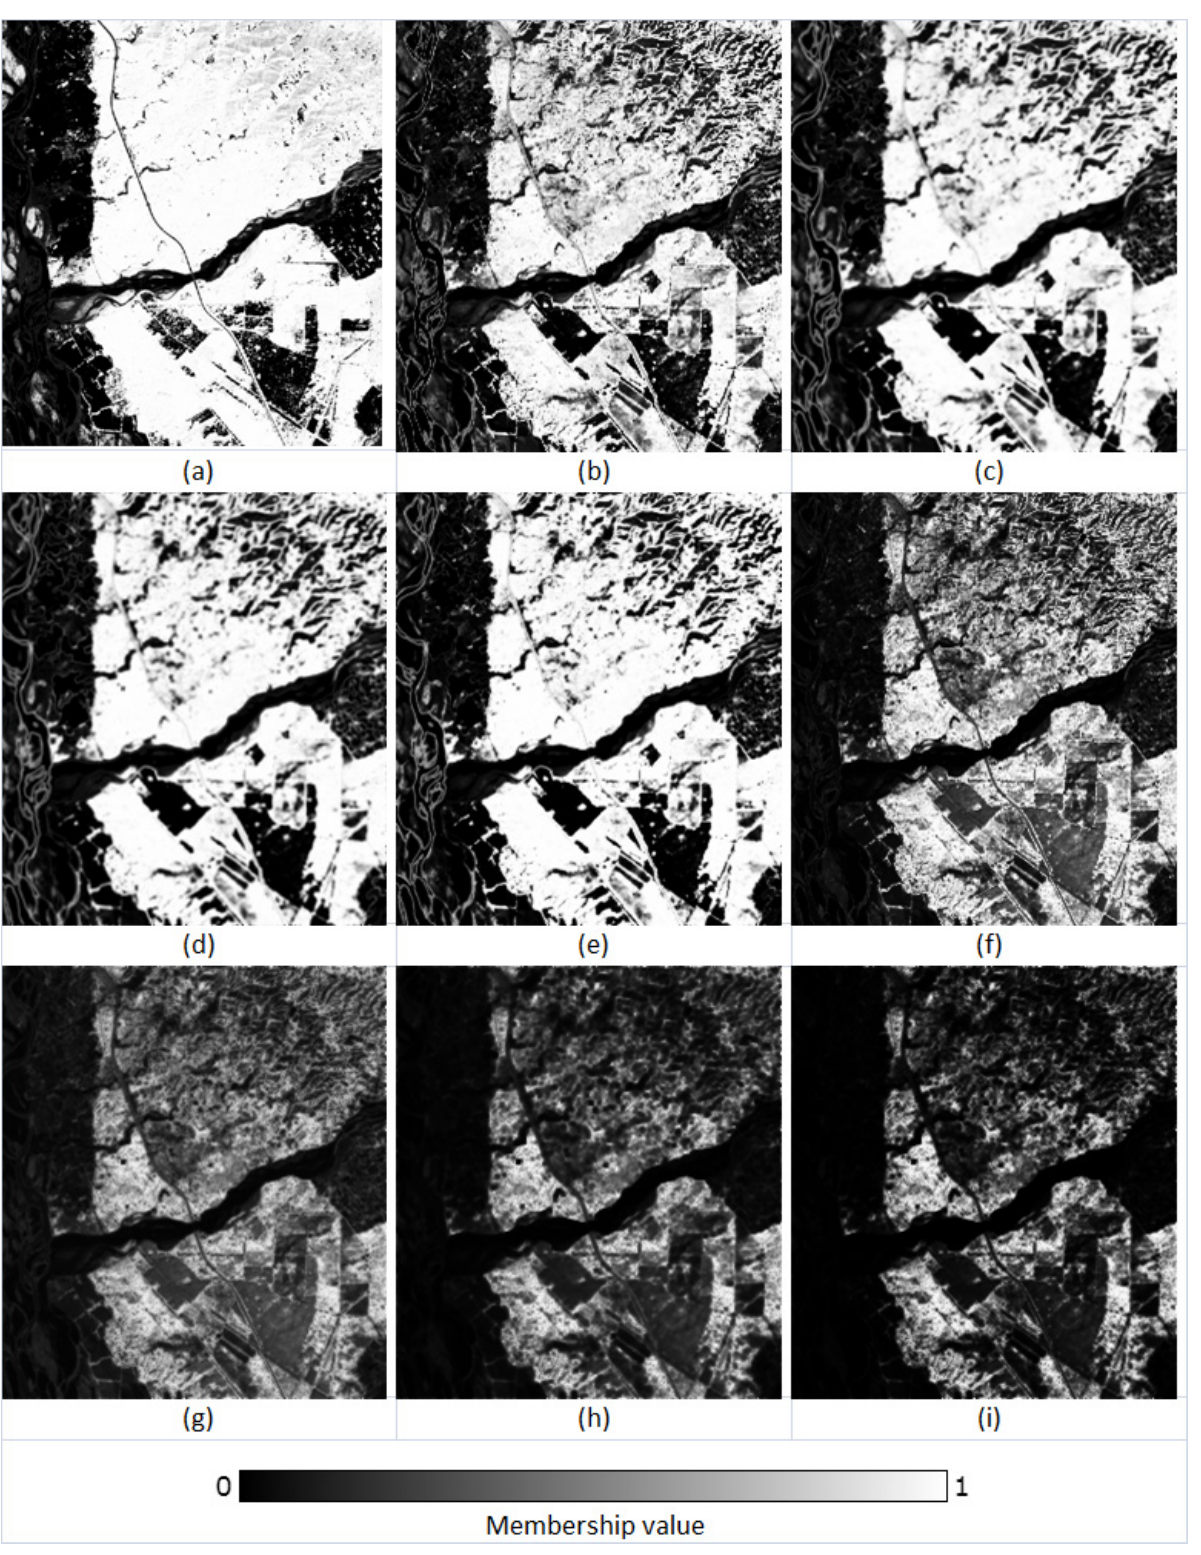
Figure 4. The membership fraction (0–1) for the class ‘Dense Forest’ in ( a ) reference, ( b ) FCM output, ( c ) FCM-S output, ( d ) FLICM output, ( e ) ADFLICM output, ( f ) PCM output, ( g ) PCM-S output, ( h ) PLICM output, and ( i ) ADPLICM output.